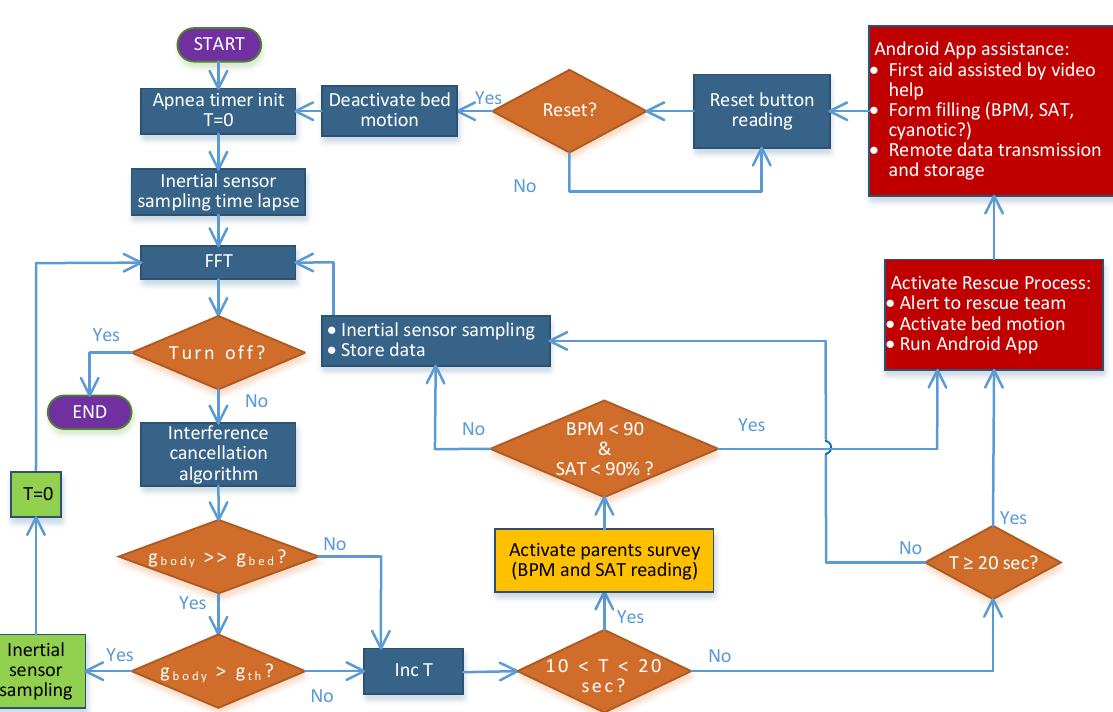
Figure 4. Proposed flowchart of the monitoring strategy to manage the data during an apnea event. At the beginning of the monitoring, a timer (T) is started to count the duration of delays between breaths. We simultaneously acquire the signals from accelerometers and IR (perpendicular to the abdomen accelerometer) to reduce uncertain data, as described in the simulation experiment. When the breathing activity cannot be identified due to in- terferences, the timer is never set to zero. If the acceleration measured by the accelerome- ter applied on the abdomen (g body ) is greater than the one measured on the bed (g bed ), it means that the signal from the breathing sensor is clearly detected. Then, it can be com- pared with a threshold level (g th ), indicating the acceleration value related to displace- ment, in order to verify if there is an apnea or not. In the case of T being less than 10 s (which is the limit risk condition), the timer is reset and the monitoring loop starts again. If T is between 10 and 20 s, an apnea alert is generated, and the platform activates the parent survey to acquire both saturation (SAT) and beats per minute (BPM) to evaluate the real status of the newborn. When both SAT and BPM are below 90, we are in a critical condition and the rescue process will be activated. On the contrary, the movement anal- yses restart. When it is not possible to obtain a clear g body signal for more than 20 s continuously, the timer is updated, activating the rescue process sending an alert to an Android app on the dedicated tablet. Then, the software enables the hardware port and its coupled relay to control any installed automatic actuator (bed motion). The mobile app counts the num- ber of alerts (extracted from data uncertain or not), stores all the available data (tempera- ture, humidity, acceleration, and displacement), and runs the user interface for the appli- cation to help a non-expert rescuer. The smart controller (Figure 5a) was equipped with a human – machine interface con- nected via a Bluetooth module assuring a proximity control. In this way, we can prevent any possible intrusion and software corruption. Moreover, in case of a lost connection, the mobile app tries to reconnect itself, and if it fails, a sound alert is activated.